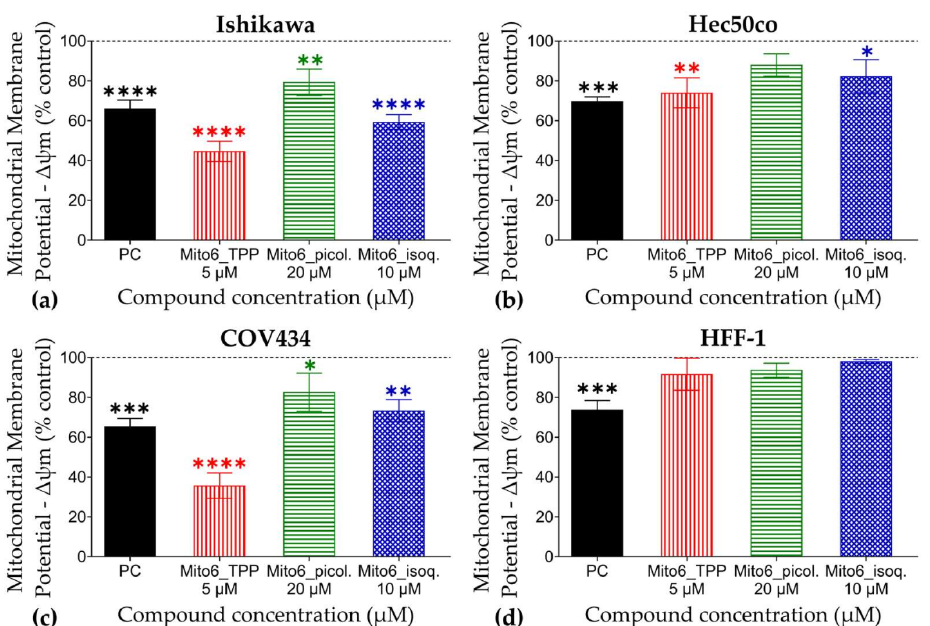
Figure 7. Mitochondrial membrane potential ( ∆ ψ m) of Ishikawa ( a ), Hec50co ( b ), COV434 ( c ), and HFF-1 ( d ) cells after 48 h of incubation with 5 µ M of Mito6_TPP, 20 µ M of Mito6_picol., or 10 µ M of Mito6_isoq. Untreated cells containing only the respective cell medium and 2% FBS were used as control and are represented as a dotted line at 100%. Carbonyl cyanide m-chlorophenylhydrazone (CCCP) (50 µ M) was used as the positive control (PC). Results are compared to the control and expressed as mean ± SEM of at least three independent experiments performed in triplicate. Signifi- cant differences between treated and untreated cells are described as * ( p < 0.05), ** ( p < 0.01) and *** ( p < 0.001), and **** ( p <